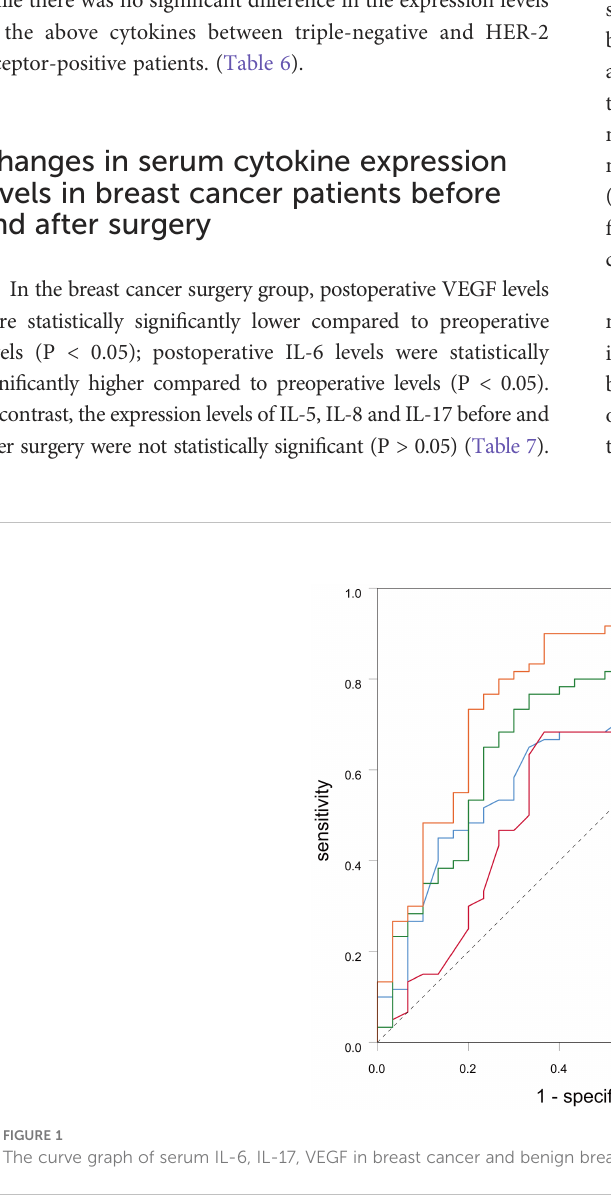
AUC, Area under the curve. Joint Diagnosis: Co-diagnosis with IL-6, IL17 and VEGF. Values in bold represent statistically signi fi cant results